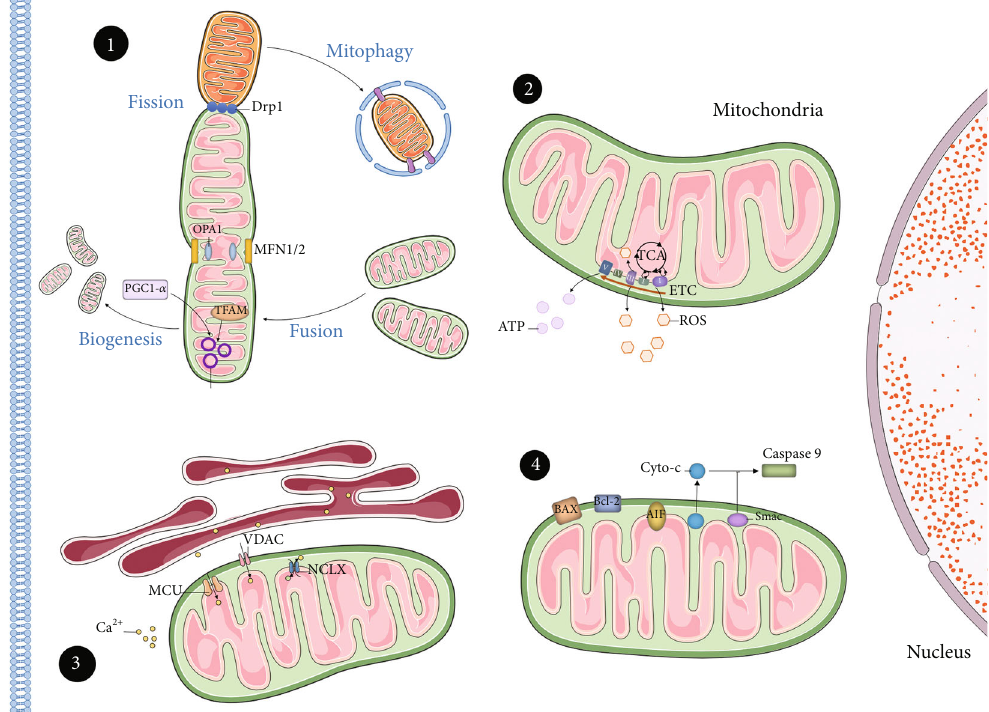
Figure 1: Mitochondrial dysfunction mechanism of spiral ganglion neurons in auditory neuropathy. Although mechanisms of mitochondrial dysfunction have not been illustrated distinctly, damages in following targets have been mentioned: (1) mitochondrial homeostasis including biogenesis, dynamics, and mitophagy; (2) redox homeostasis and energetic metabolism; (3) mitochondrial calcium homeostasis; and (4) proapoptotic signal in mitochondria. Drp1: dynamin-related protein 1; MFN1/2: mitofusin 1/2; OPA1: optic atrophy 1; PGC1- α : peroxisome proliferator-activated receptor γ coactivator-1 α ; TFAM: mitochondrial transcription factor A; TCA: tricarboxylic acid; ETC: electron transport chain; MCU: mitochondrial calcium uniporter; VDAC: voltage-dependent anion channel; NCLX: Na+/Ca2+/Li+ exchanger; Bcl-2: B cell lymphoma-2; BAX: Bcl-2 associated protein X; AIF: apoptosis inducing